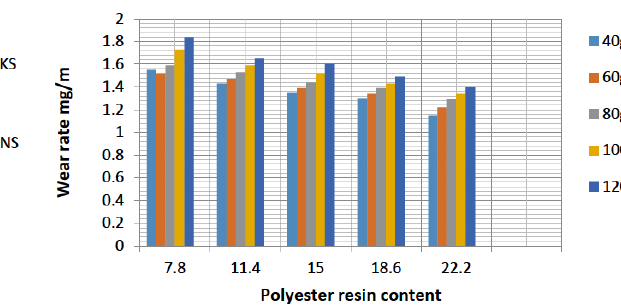
Figure 6: Rockwell Hardness values of PKS & CNS / Polyester com- posites for 420 µ m sieve size